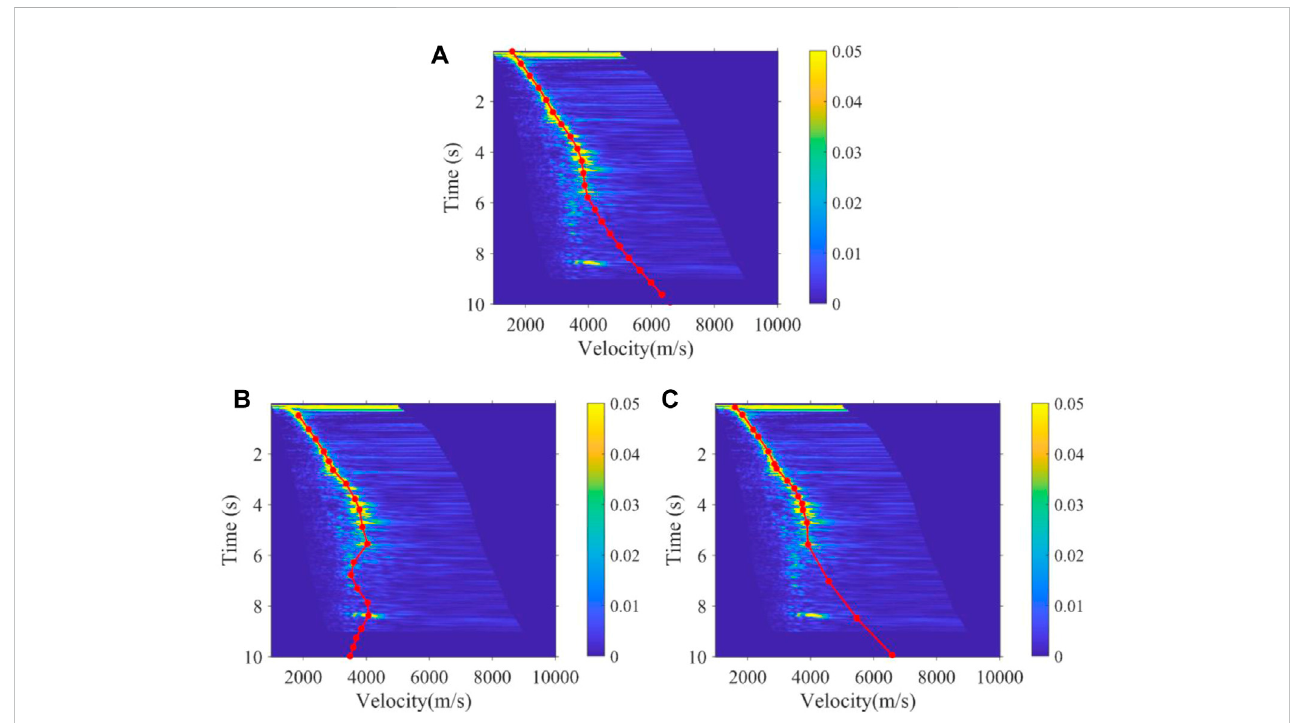
FIGURE 12 Velocity function of the 3500th velocity spectrum obtained by (A) manual, (B) K-means, and (C) the method proposed.